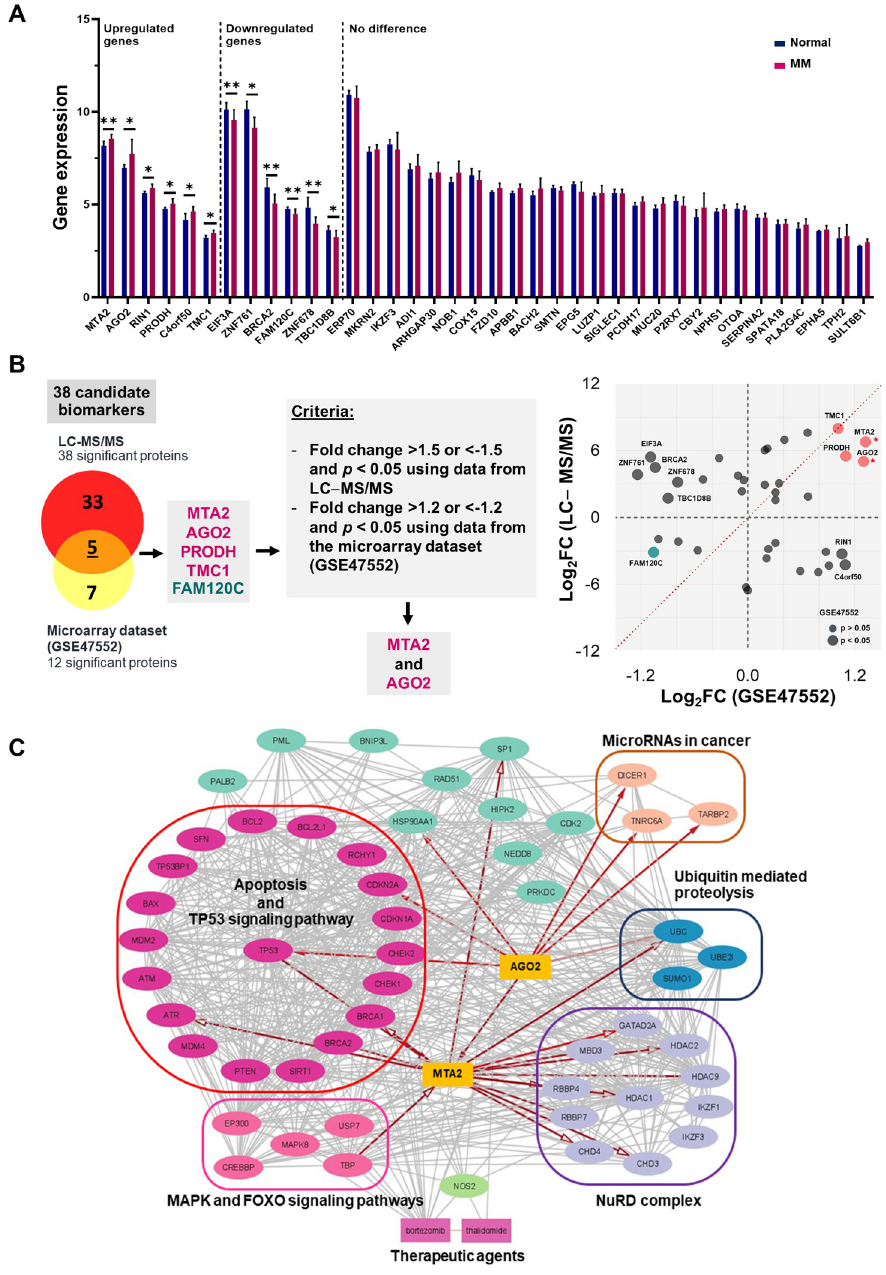
Fig 3. Analysis of gene expression profile corresponding to 38 dysregulated proteins and identifying of candidate biomarkers. (A) The expression profiles of the genes involving 38 dysregulated proteins among 41 patients with MM compared with 5 normal controls using the data from GSE47552 [27]. Bar chart showing the relative gene expression levels of genes involving 38 dysregulated proteins. The significant p -value less than 0.05 and 0.01 are represented with � and �� , respectively. (B) Selecting of the candidate biomarkers. (C) KEGG pathway enrichment-based PPI network analysis. The top candidate proteins, MTA2 and AGO2 (gold-yellow), were predicted to be central mediators of multiple signaling